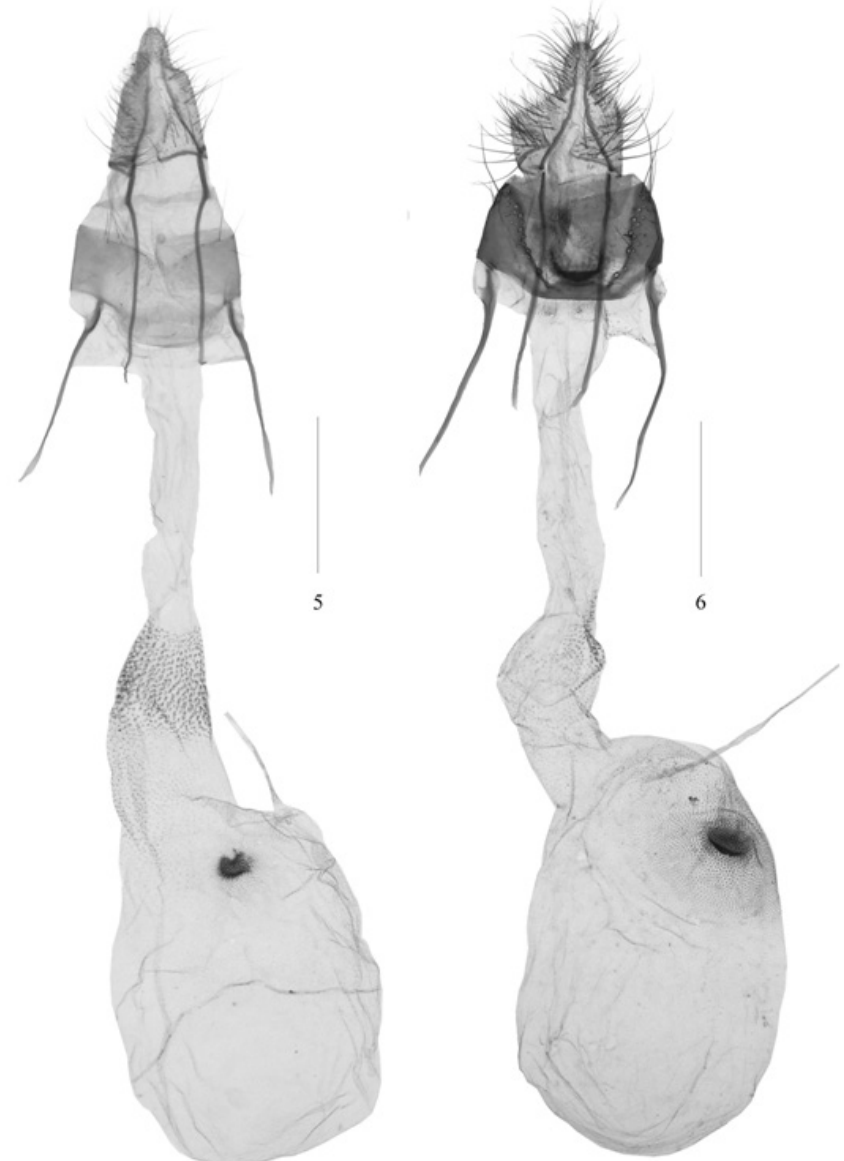
Figures 5−6. Female genitalia structures of Pseudacrobasis species: 5 P . dilatata sp. n., slide No. LHX14109 6 P . tergestella , slide No. YLL15177. Scale bars: 0.5 mm. on posterior margin. Apophyses posteriores slightly longer than apophyses anteriores. Antrum oval, weak-sclerotized. Ductus bursae with posterior 3/5 smooth, moderate in width, anterior 2/5 gradually broadened, with dense spinules from anterior 1/5